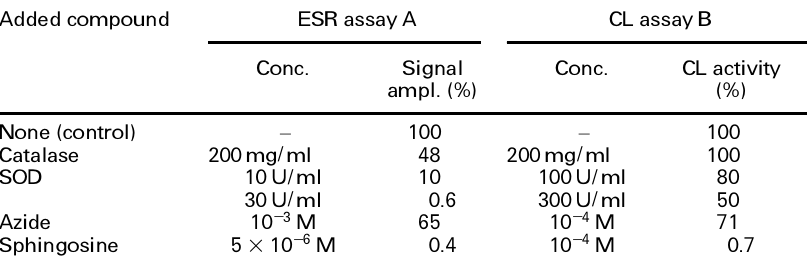
Table 1. Comparison of the effects of SPN and two classical inhibitors of PMN activation on ESR signal amplitude (A) and CL activity (B) Added compound ESR assay A CL assay B Conc. Signal Conc.